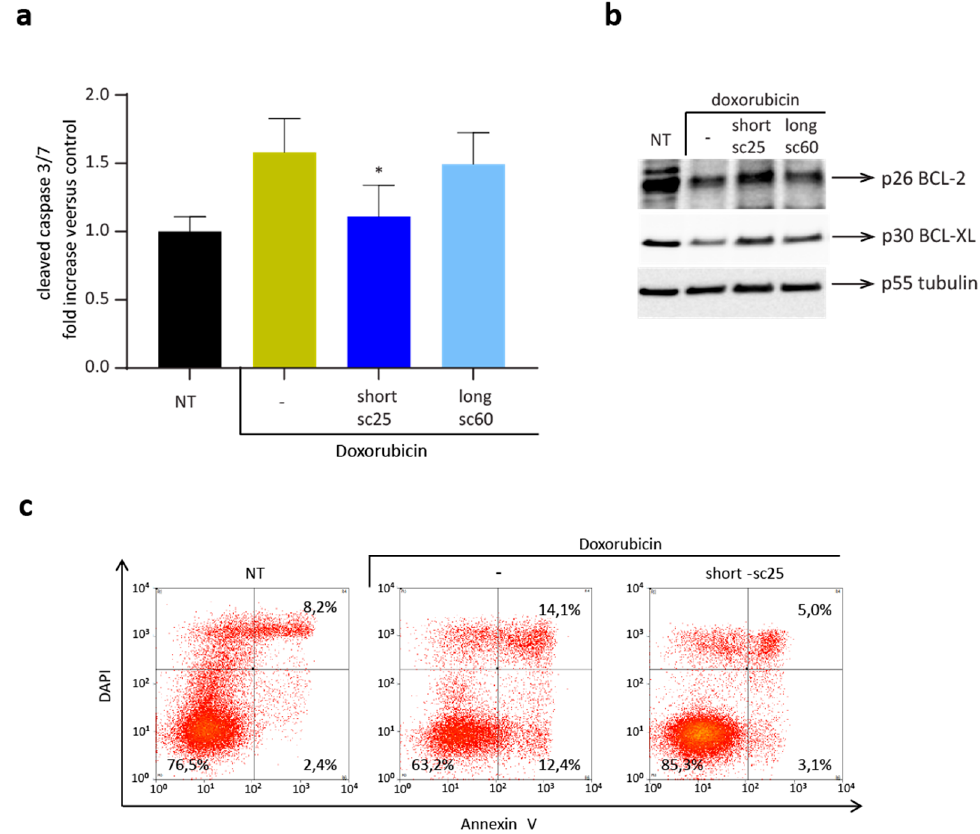
Figure 6. Short-sc25 protects normal cells from apoptosis induced by doxorubicin. ( a ) Analysis of caspase-3 activation in H9C2 cells treated with short-sc25 or long-sc60 (100 nM) for 3 h and then exposed to doxorubicin (25 µM) for 1 h. Graph represents cleaved caspase-3 activity expressed as fold increase versus control. Samples are in triplicate; bars represent standard deviations. * p < 0.05 T-test of doxorubicin + short-sc25 treated cells versus doxorubicin alone. NT, Non-Treated cells. ( b ) Immunoblotting analysis of lysates from H9C2 cells treated as in ( a ); activation of anti-apoptotic pathways was determined evaluating BCL-2 and BCL-xL protein expression. Tubulin (p55) was analyzed as loading control. ( c ) Flow cytometry analysis of HPDE cells treated with short-sc25 (100 nM) for 24 h, exposed to doxorubicin (4 µ M) for 24 h and then stained with Annexin V-APC and DAPI. Data reported in the figure are representative of at least three experiments.